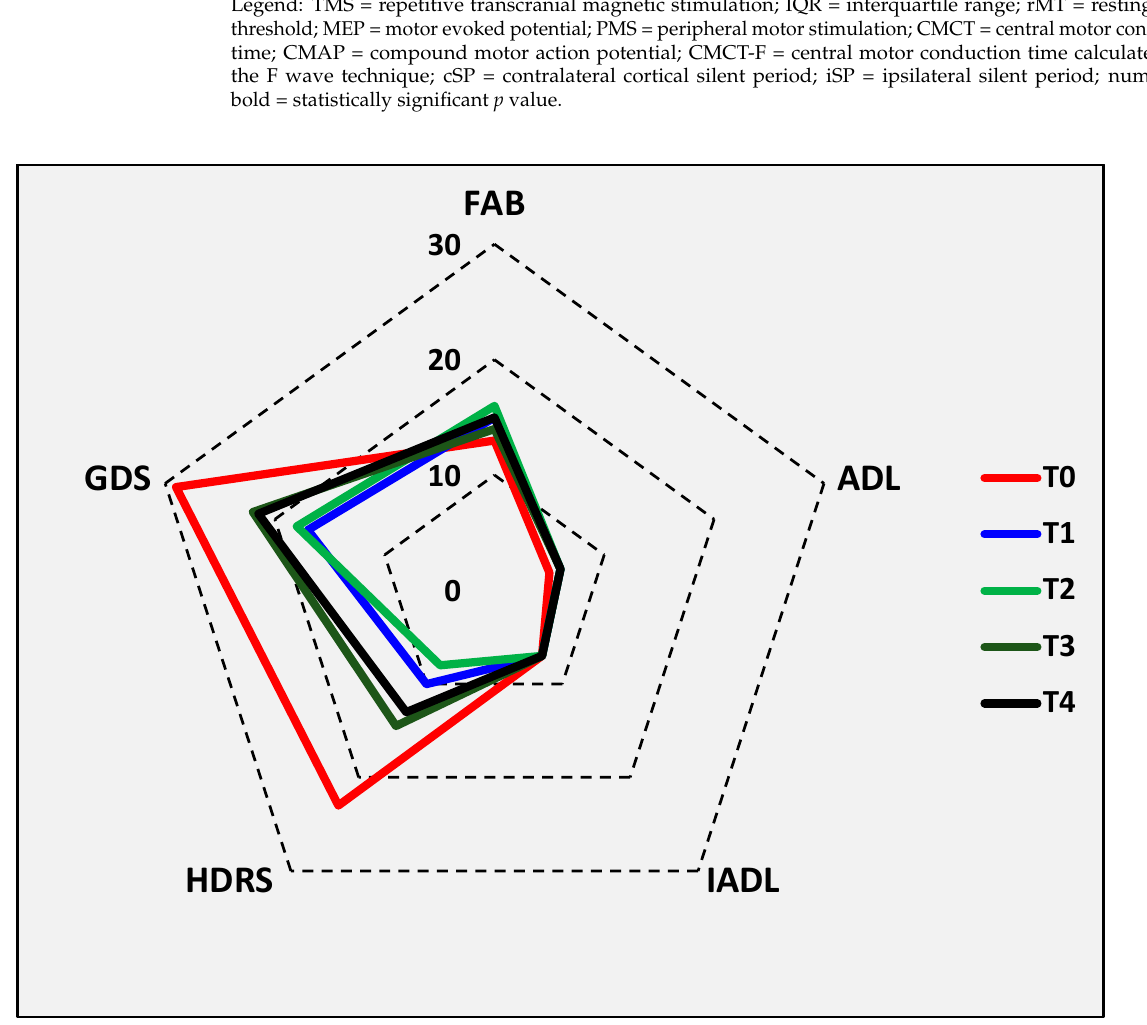
Figure 4. Graphic representation of the main neuropsychological test scores of all participants at baseline (T0) and at follow-up visits (T1–T4). ADL: Activities of Daily Living; FAB: Frontal Assessement Battery; GDS: 30-item Geriatric Depression Scale; IADL: Instrumental Activities of Daily Living; HDRS: 21-item Hamilton Depression Rating Scale. Table 3. Electrophysiological data to TMS of all participants at baseline (T0) and at follow-up (T1).